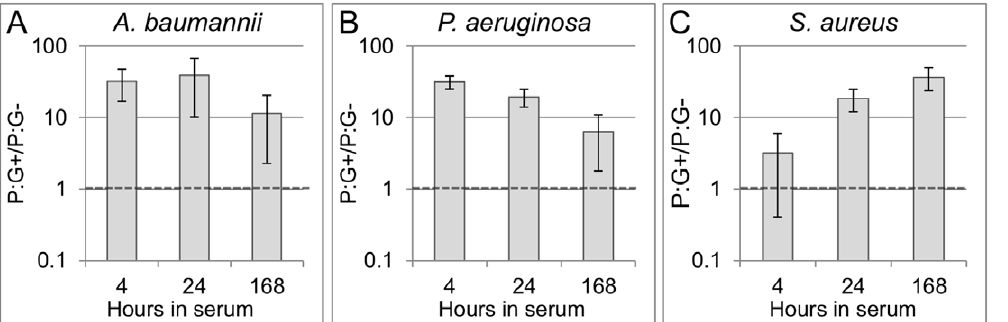
Figure 3. Ratiometric pre-rRNA analysis of A.baumannii (A), P.aeruginosa (B), and S.aureus (C) cells in serum over time. Three biological replicates for each organism were prepared at , 1E5 CFU/mL in serum and analyzed after 4, 24, and 168 hours of serum acclimation. At each timepoint, nutritional stimulation was initiated by suspending cells in pre-warmed TSB for 1.5 hours. Changes in pre-rRNA are expressed as means and standard deviations of the fold-increases in P:G ratio following nutritional stimulation, relative to non-stimulated control aliquots (P:G + /P:G 2 ). The horizontal dashed line indicates the ‘‘viability threshold’’ which samples with viable cells are expected to exceed. From separate gDNA standard curves consisting of $ five points each, qPCR efficiencies were between 1.010 and1.067.